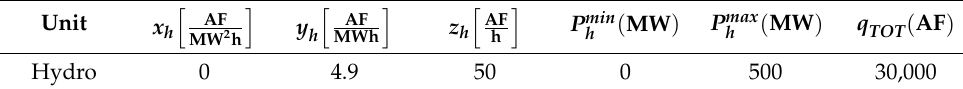
Table 3. Hydro plant characteristics.